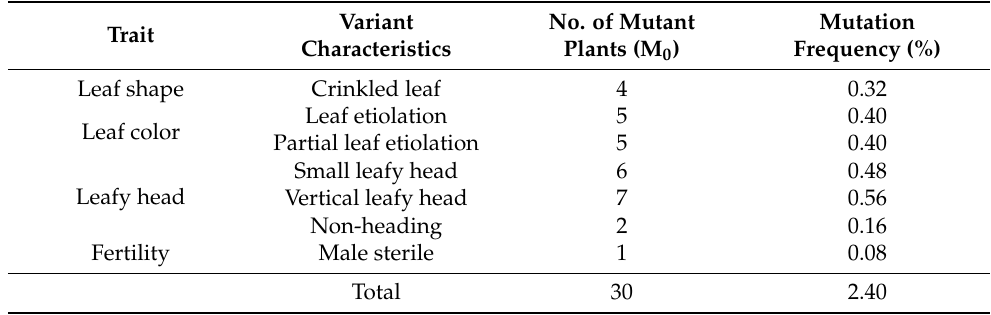
Table 1. Characterization of mutation types in M 0 plants of Chinese cabbage (microspore EMS mutagenesis).